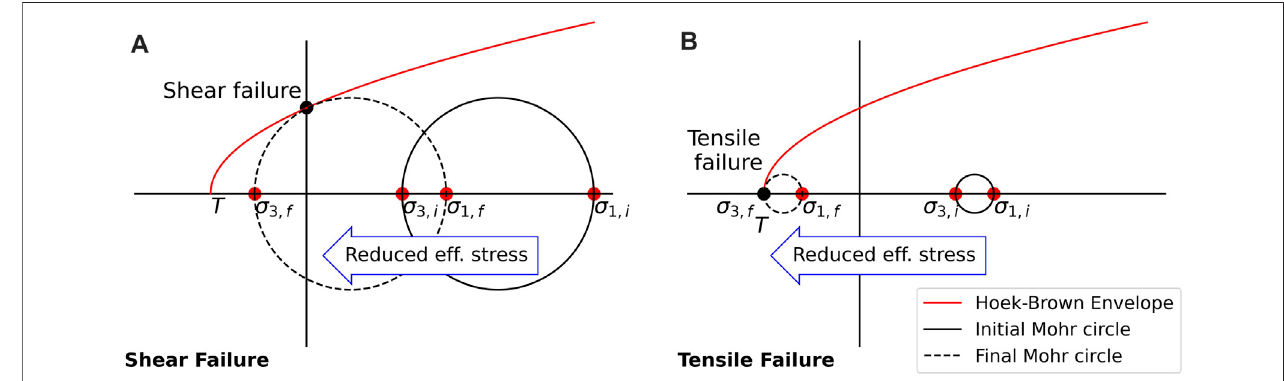
FIGURE 4 | Example movement of Mohr circle due to hydrate dissociation. Initial stresses are denoted with the subscript i . Final stresses are denoted with the subscript f .In (A) ,shearfailureoccurswhentheMohrcircleintersectstheHoek-Brownenvelopeat | σ 3 ′ | < | T | .In (B) ,tensilefailureoccurswhentheMohrcircleintersects the Hoek-Brown envelope at | σ 3 ′ | (cid:2) | T |